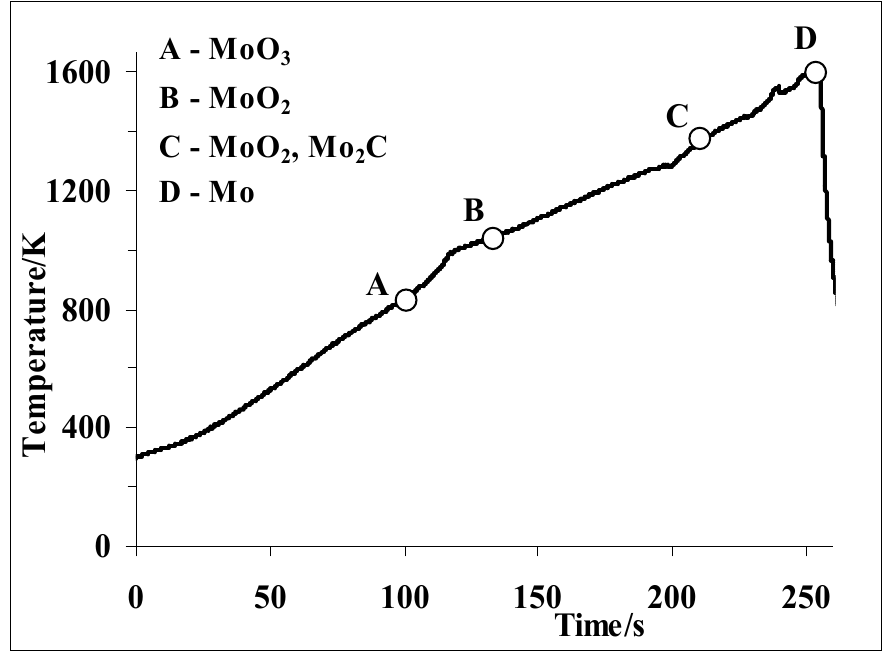
Figure 5. The heating thermogram of the MoO 3 + 2C mixture with the XRD analysis results of the quenched samples at different characteristic temperatures, A—T = 893, B—1063, C—1373, D—1573 K, V h = 300 K min − 1 .